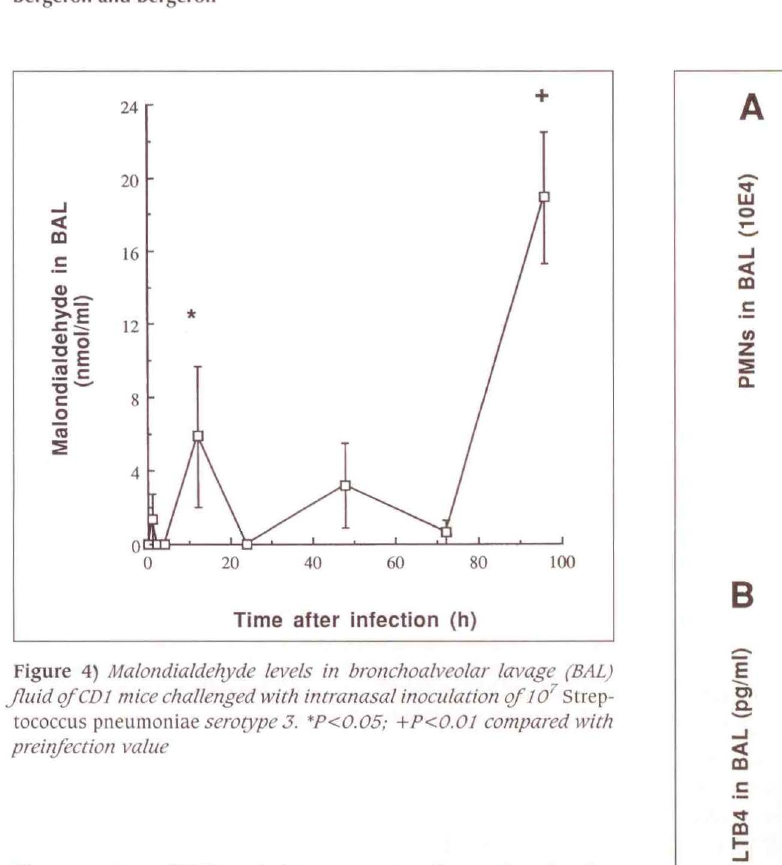
Figure 4) Malondialdehyde levels in bronchoalveolar lavage (BAL) fluid q/CDJ mice challenged with intranasal inoculation ef 10 7 Strep tococcus pneurnoniae serotype 3. *P<0.05; +P<0.01 compared with prei,ifecdon value